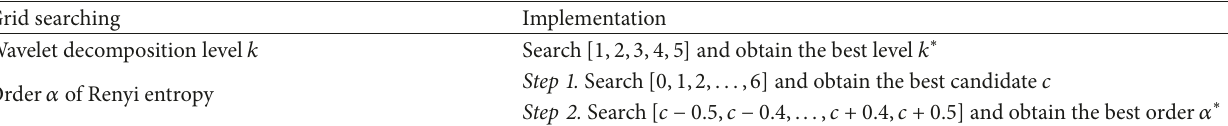
Table 2: Grid searching of hyperparameters.